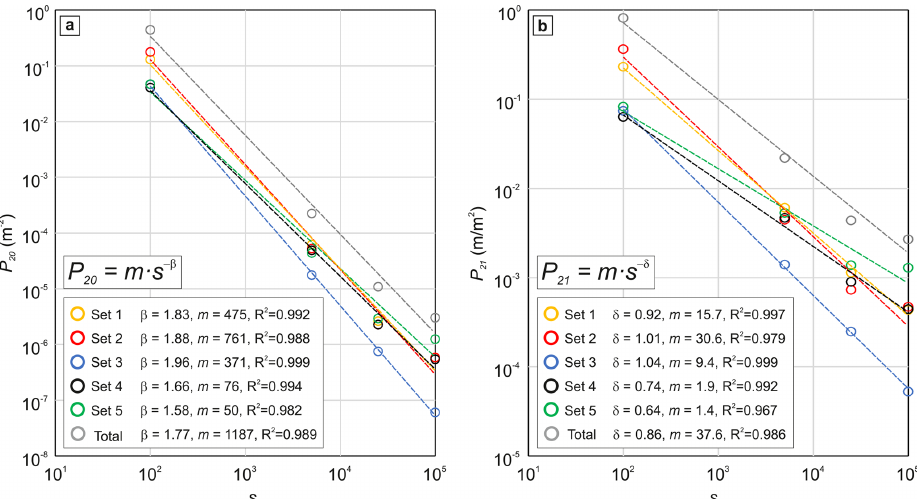
Figure 7. Lineament density ( P 20 ) and intensity ( P 21 ) variation across scales for each orientation set (Sets 1 to 5) and for the entire lineament network (total).